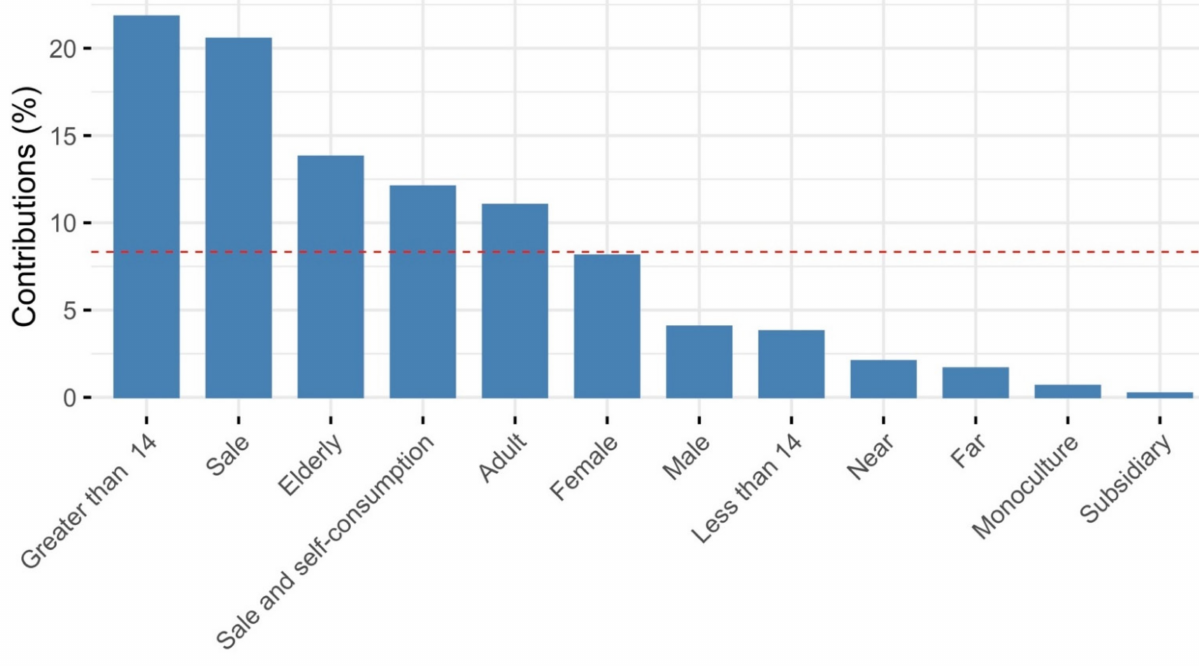
Figure A2. Contribution of variables to dimension